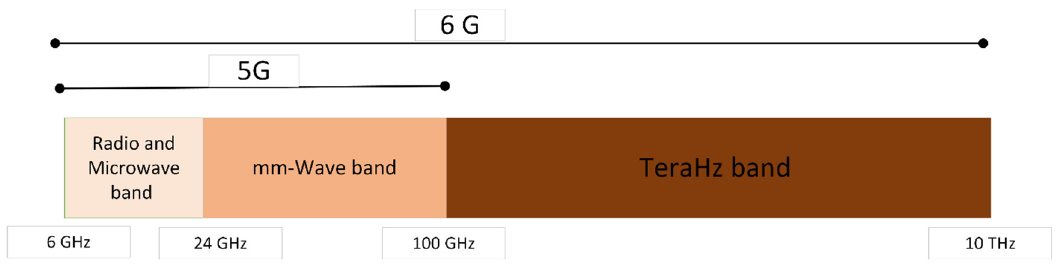
Figure 8. Spectrum ranges in HetNet. Table 5. Summary of the related work for spectrum allocation.